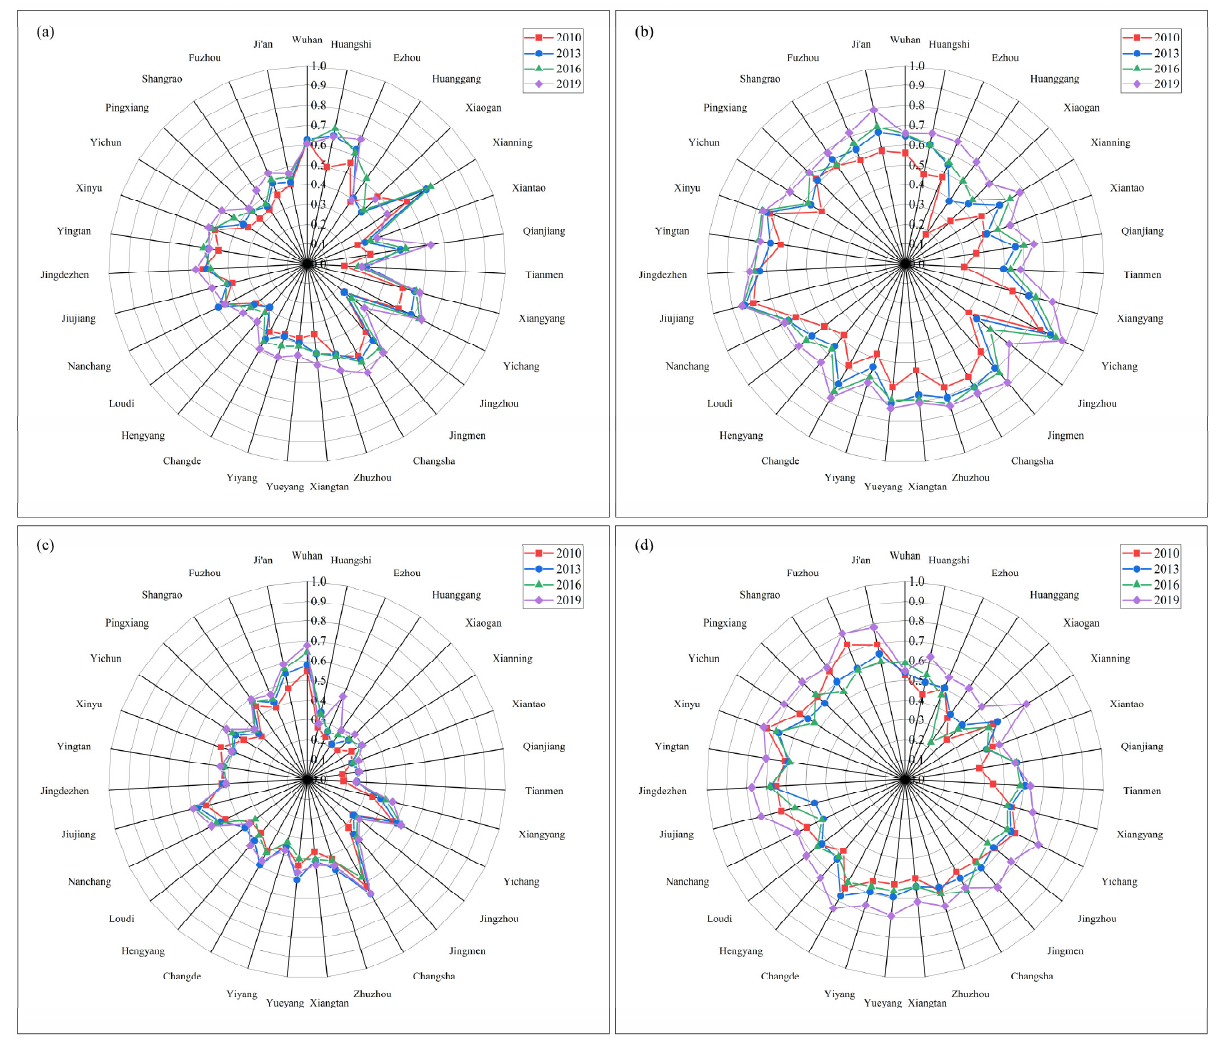
Figure 9. CCD of EE and the HQED subsystem: ( a ) The CCD of EE and the innovative development subsystem; ( b ) The CCD of EE and the coordinated development subsystem; ( c ) The CCD of EE and the open development subsystem; ( d ) The CCD of EE and the shared development